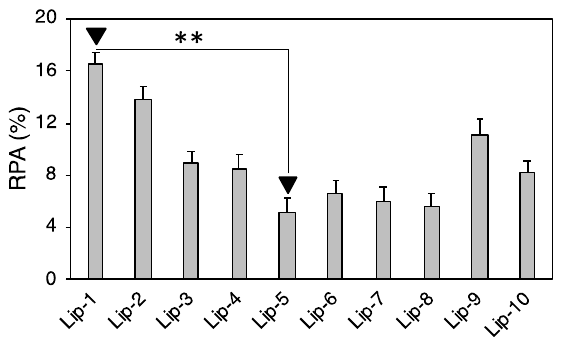
Figure 4. Relative protein abundance of biomolecular corona fingerprints. Lip-1 and Lip-5 were the liposomal formulations with the highest and lowest enrichment in PCFs (Vitronectin, APOA1, APOA2, APOB, APOC2, Ig heavy chain V-III region BRO, vitamin K-dependent protein, and Integrin beta3). Significance was statistically evaluated by Student’s t -test (** p < 0.05).